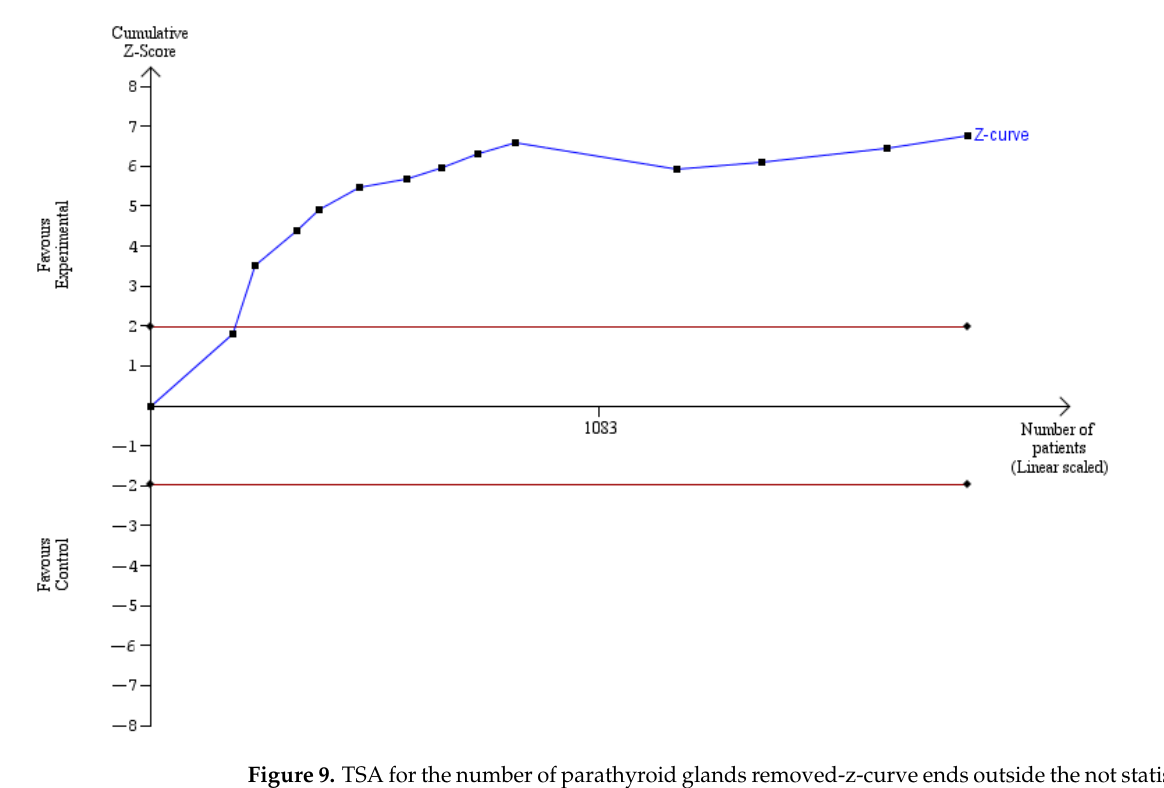
Figure 9. TSA for the number of parathyroid glands removed-z-curve ends outside the not statistically significant zone.